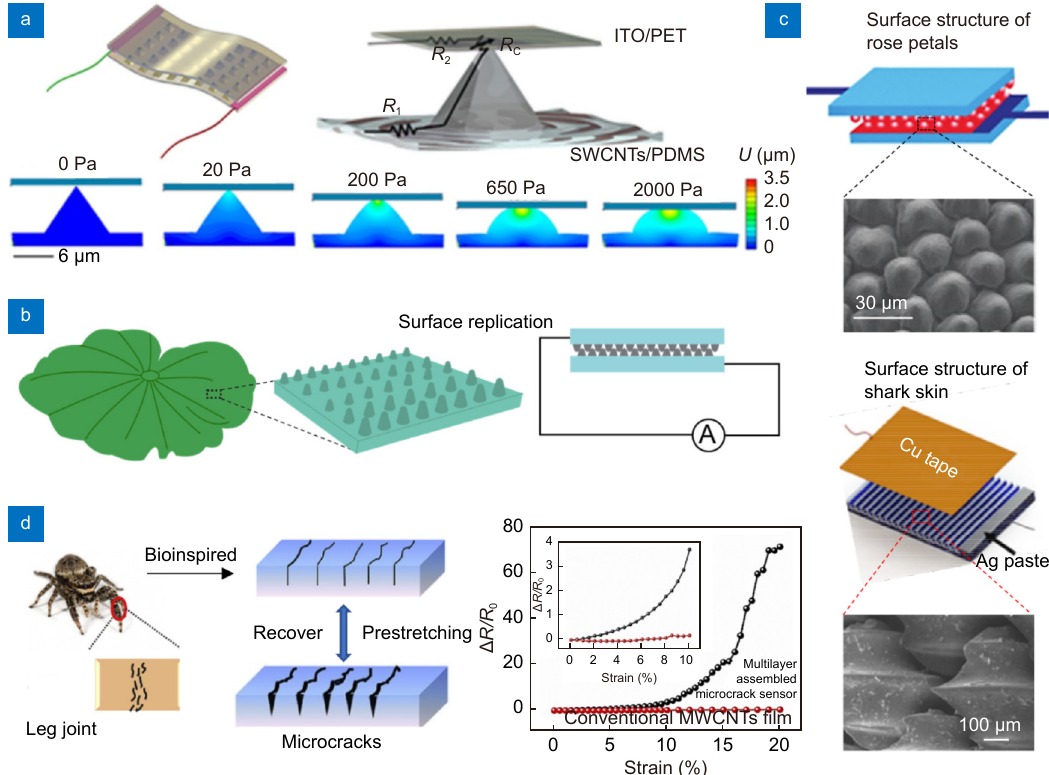
Fig. 4 | Piezoresistive design and manufacture with singular structure. ( a ) Piezoresistance of an artificial structured sensor based on con- tact area changes 91 . ITO, indium tin oxide; PET, polyethylene terephthalate; SWCNTs, single-walled carbon nanotube; PDMS, polydimethylsilox- ane. ( b ) Scheme illustrating the lotus-leaf-inspired piezoresistive design and assembly 98 . ( c ) Scheme illustrating the rose-petal-inspired piezores- istive design and assembly 99 and the shark-skin-inspired piezoresistive design and assembly 101 . ( d ) Scheme illustrating the spider-leg-joint-in- spired piezoresistive design with plenty of cracks 102 . Figure reproduced with permission from: (a) ref. 91 , (d) ref. 102 , Elsevier; (c) ref. 101 , Elsevier and ref. 99 , Royal Society of